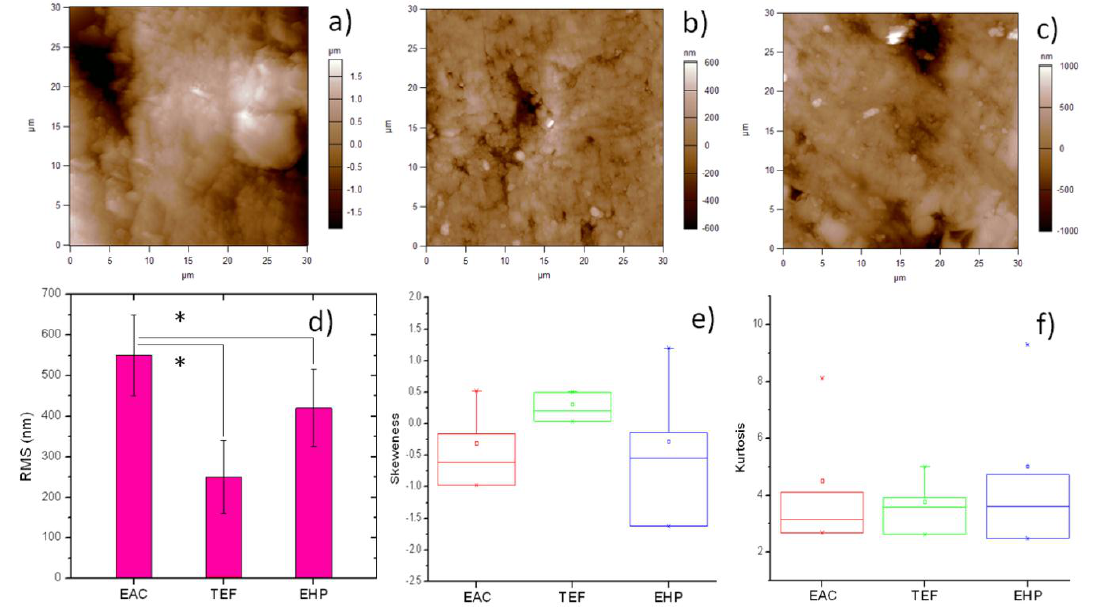
Figure 2. Examples of typical 3D surface morphology resulting from 30 µm AFM scan size of the different composites after standard polishing: ( a ) EAC; ( b ) TEF; and ( c ) EHP; ( d – f ) statistical plots of the quantities of interest extracted from AFM figures such as in Figure 2, namely ( d ) RMS roughness S q (bar plot); ( e ) skewness S sk ; and ( f ) kurtosis S ku , respectively (box plots). For S q in ( d ), the asterisk represents statistically significant differences, (*: p < 0.05).